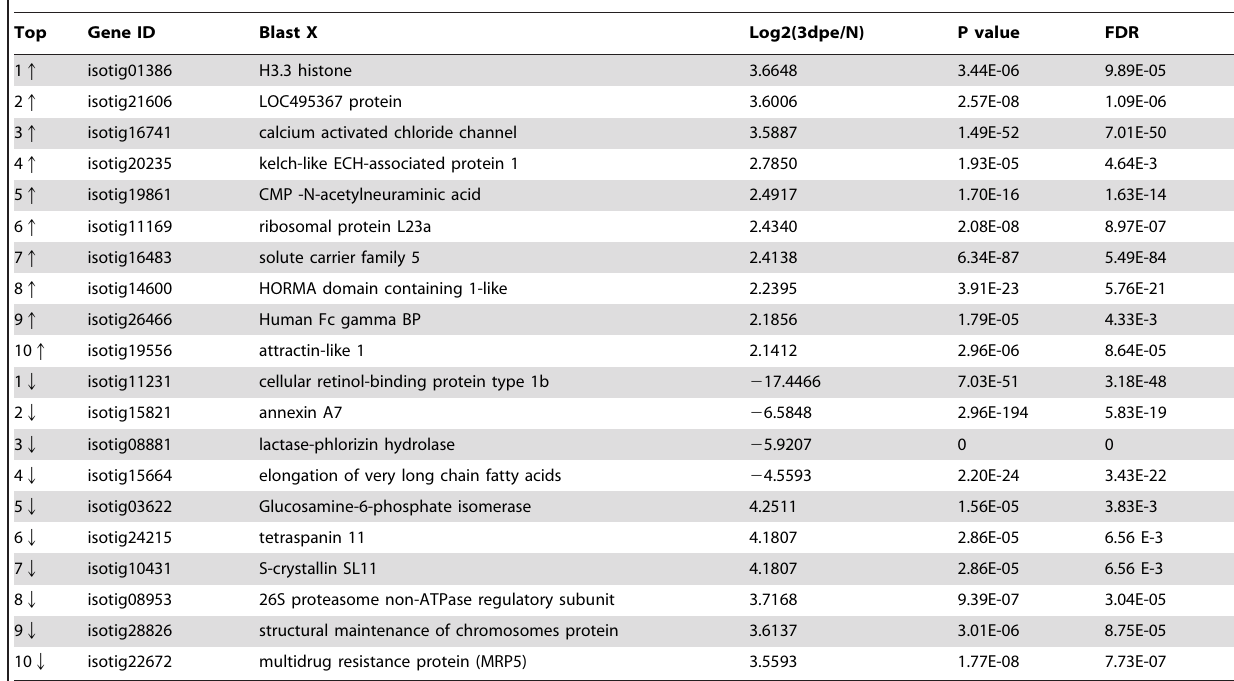
Table 6. Top 10 differentially expressed genes at 3dpe vs